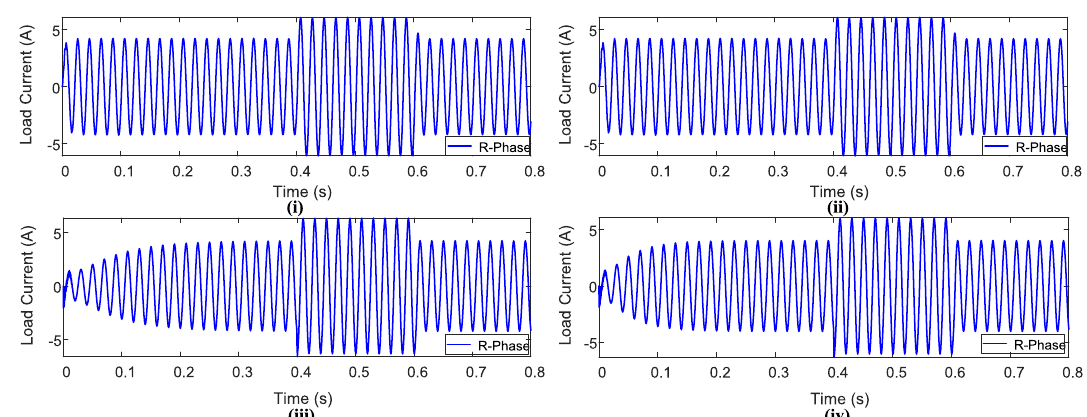
Fig. 15 Load current (i) Droop (ii) VSM (iii) VOC (iv)